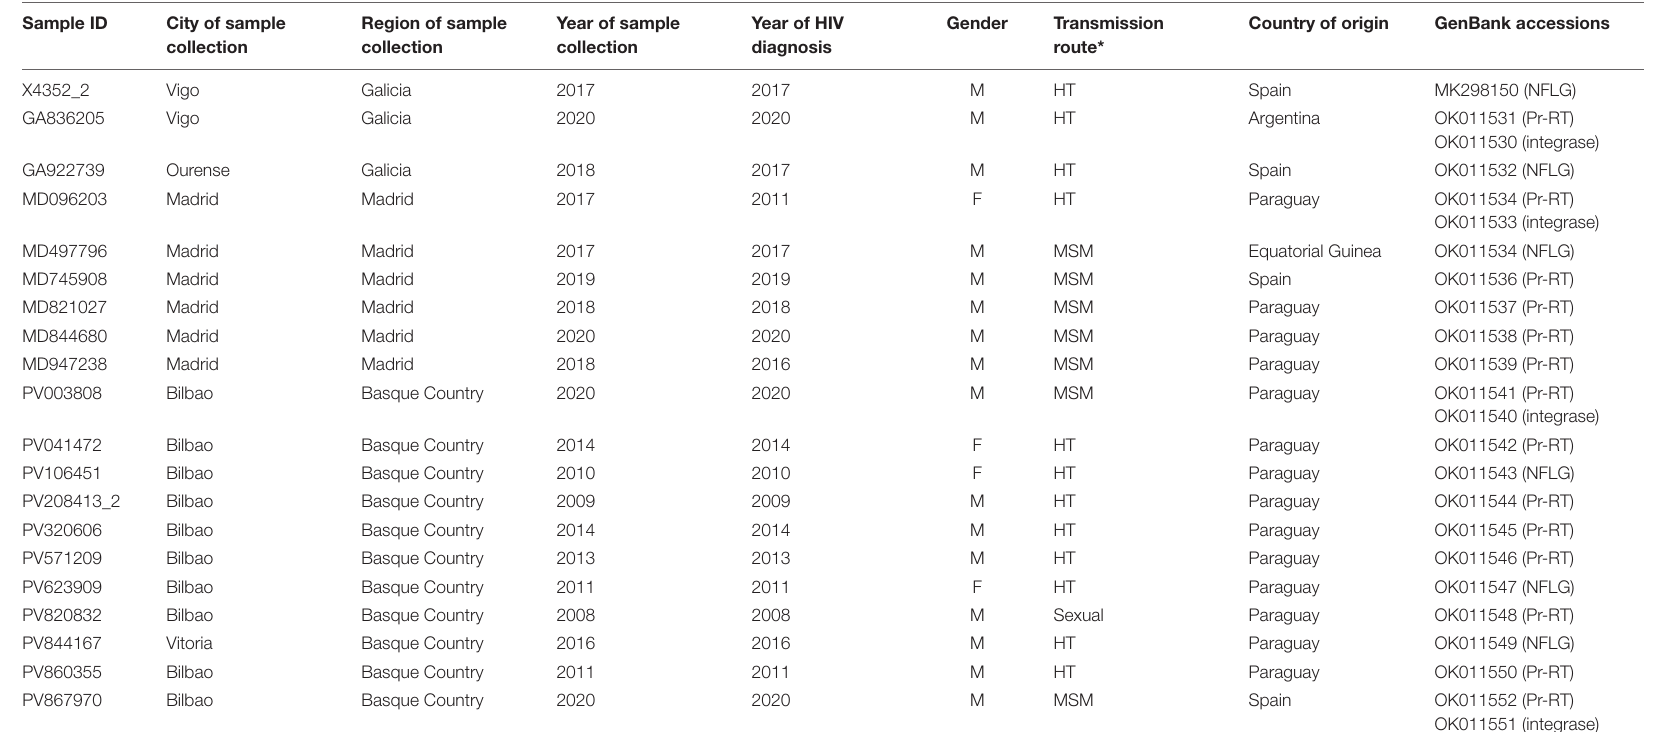
TABLE 1 | Epidemiological data of patients and GenBank accessions of